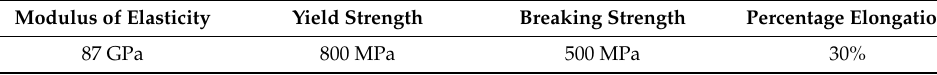
Table 3. The mechanical properties of NiTiNb SMA.